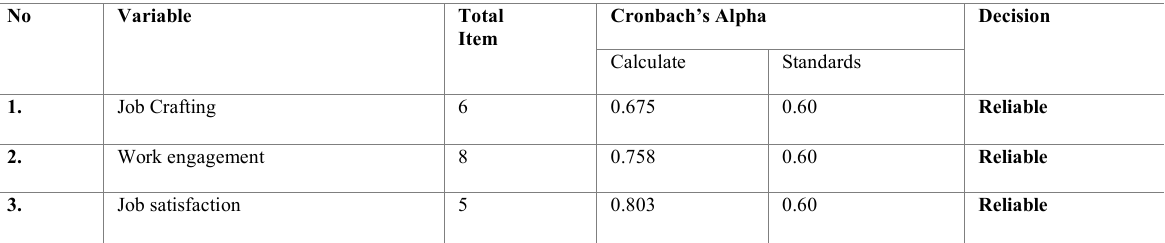
Table 2: Reliability Test